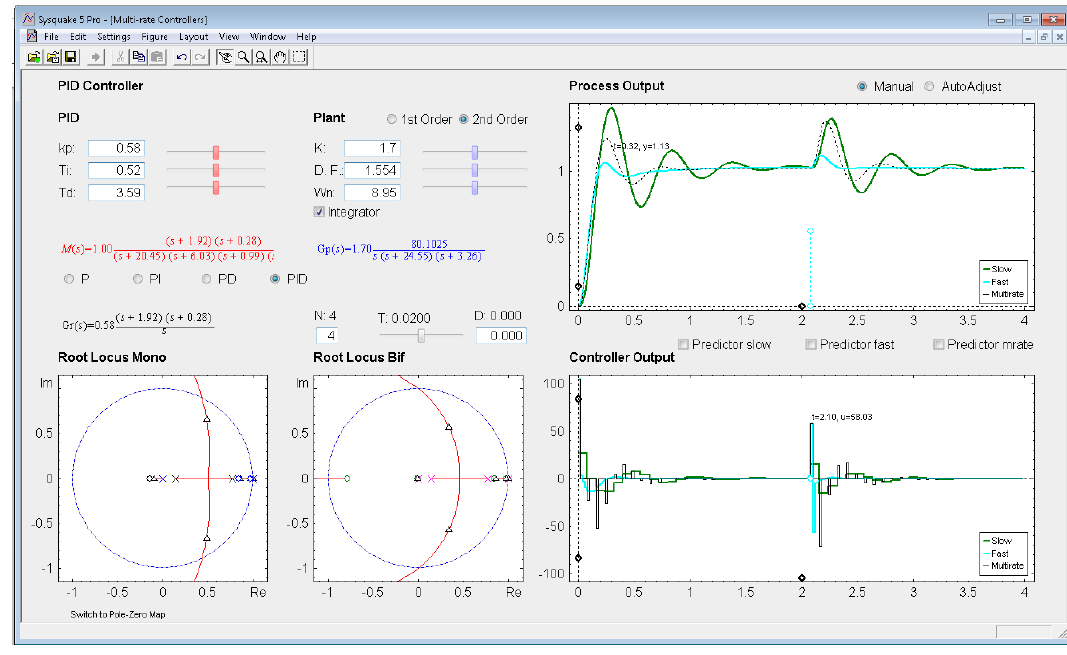
Figure 11. Slow-rate and dual-rate root locus